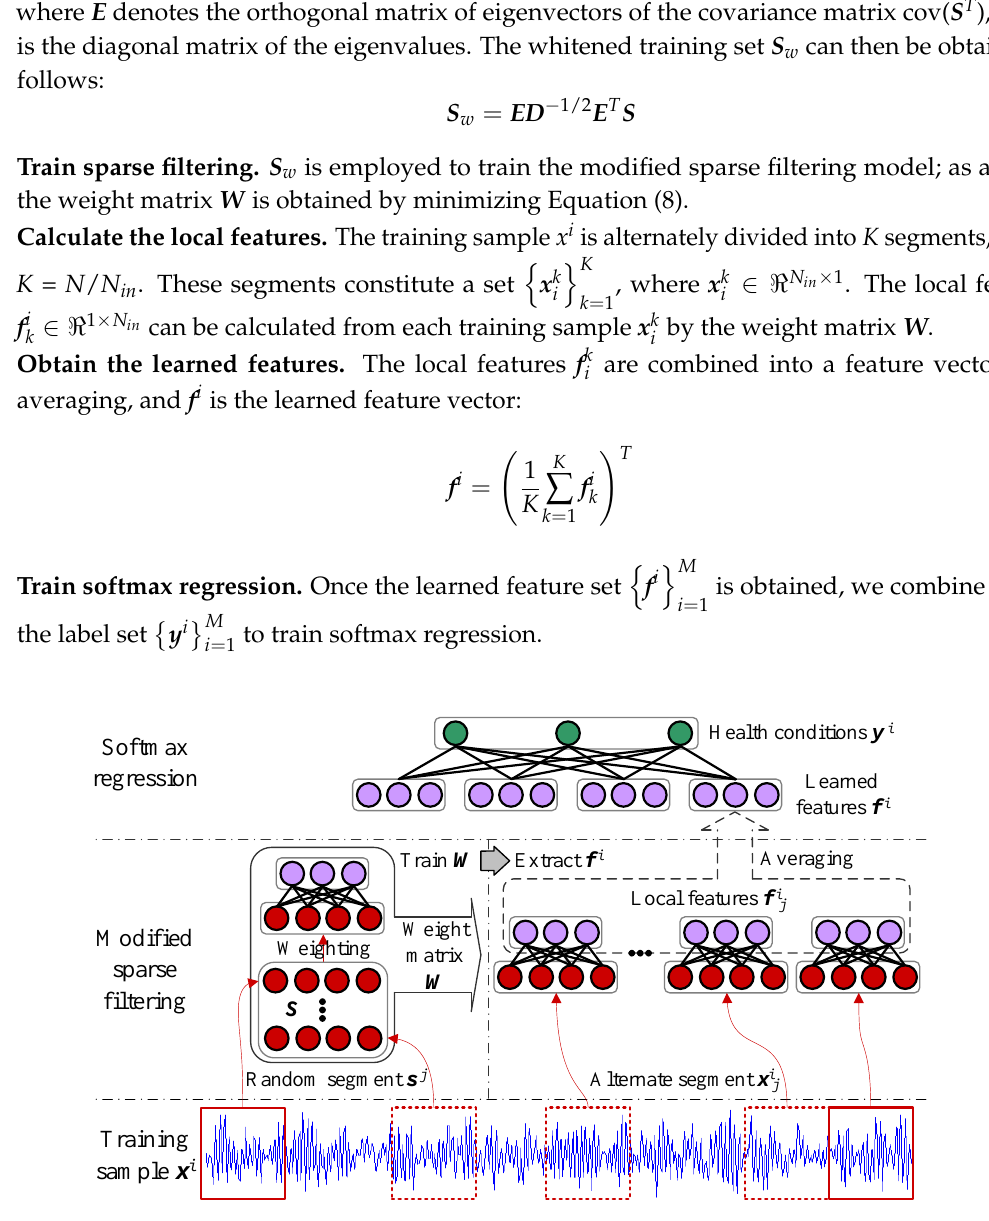
Figure 10. Illustration of the proposed two-stage learning method.